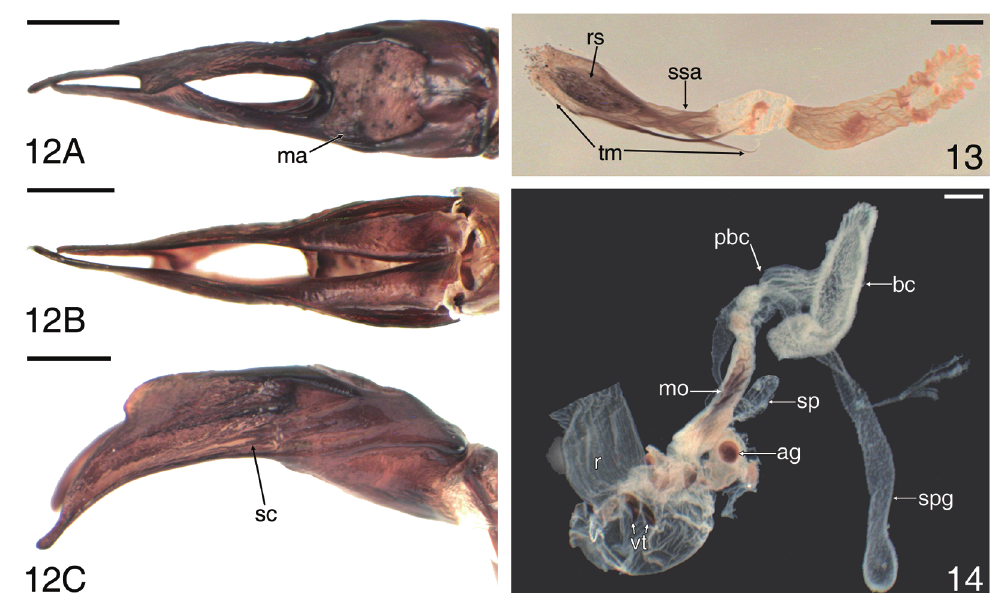
Figs 12–14. Morphotype V “ Sinensis ”. 12–13 . Male genitalia of M. sinensis (Hope, 1842), lectotype (BMNH). 12 . Parameres in dorsal (A), ventral (B) and lateral (C) views. 13 . Endophallus and temones in ventral view. 14 . Female genitalia of M. dalatensis Frey, 1970, holotype (NHMB) in lateral view. Scale bars = 1.0 mm.